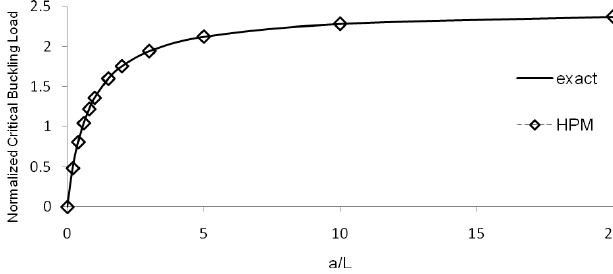
Figure 3. Variation of normalized critical buckling loads with a/L